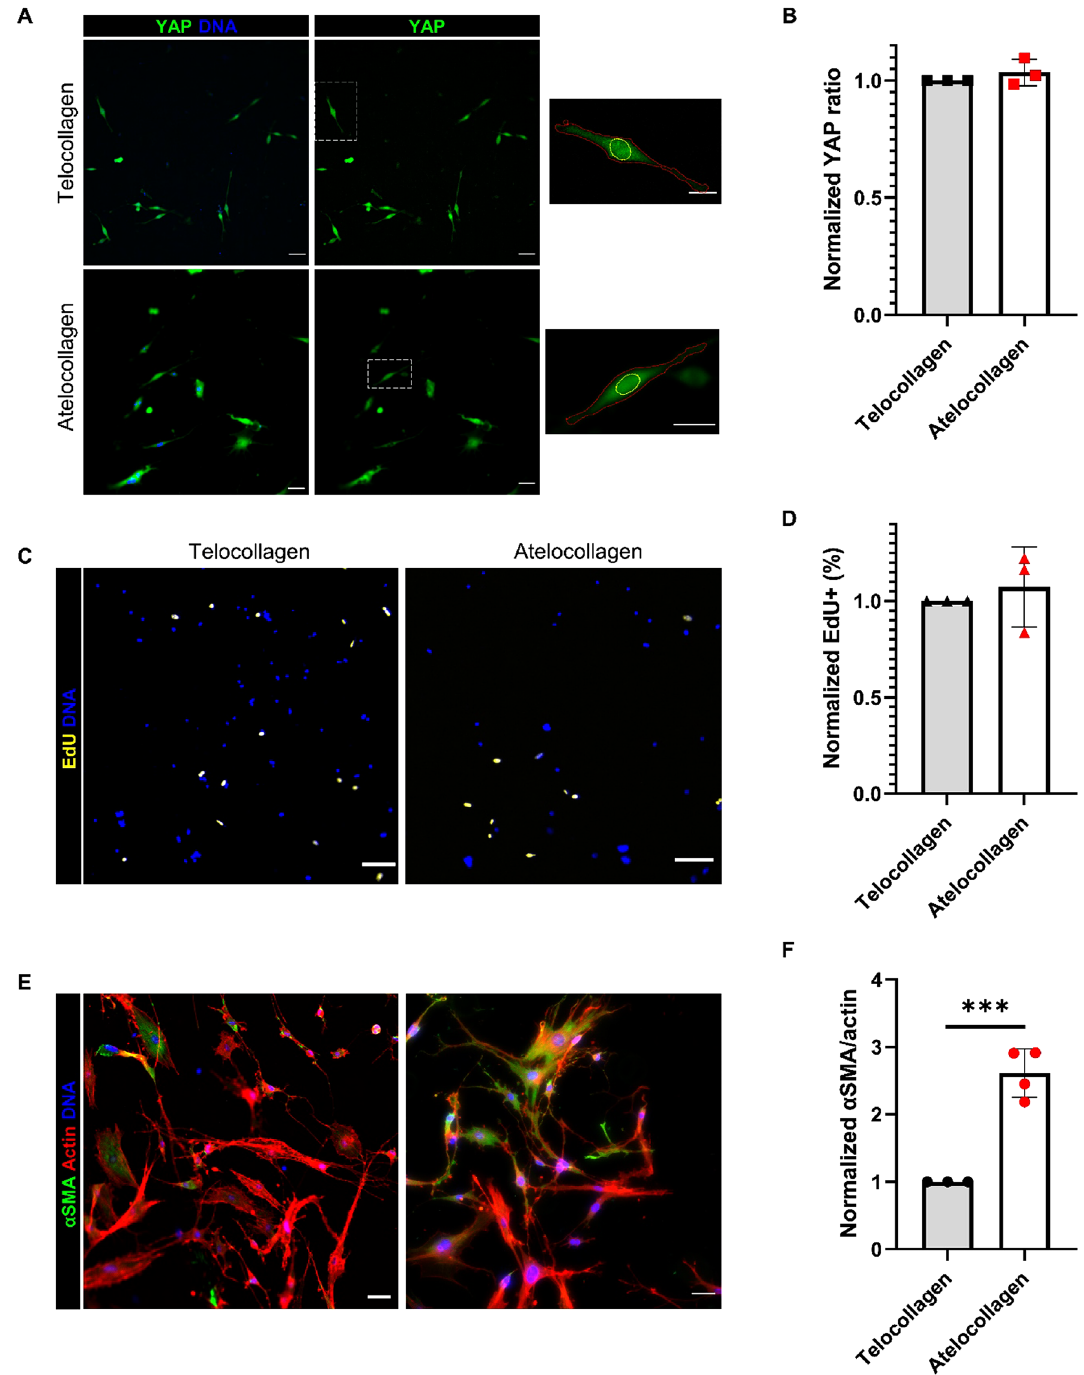
Figure 3. FAPs’ response to 3 mg/ml crosslinked and non-crosslinked collagen gels. ( A ) YAP immunofluorescence of FAPs on telocollagen and atelocollagen gels. Yellow outlines indicate nuclei and red outlines indicate cytoplasm on insets. ( B ) Quantification of YAP signal intensity to find nuclear to cytoplasmic ratio of YAP. ( C, D ) EdU signal and quantification of percent proliferating cells after 24 h EdU treatment ( E ) αSMA signaling as a measure of myofibroblast activation in FAPs. ( F ) Quantification of αSMA and actin area ratio. *** P < 0.001. Data normalized to telecollagen gels. Scales bars set to 50 µm. Scale bars for insets set to 20 µm. N = 3 mice and n = 3 independent